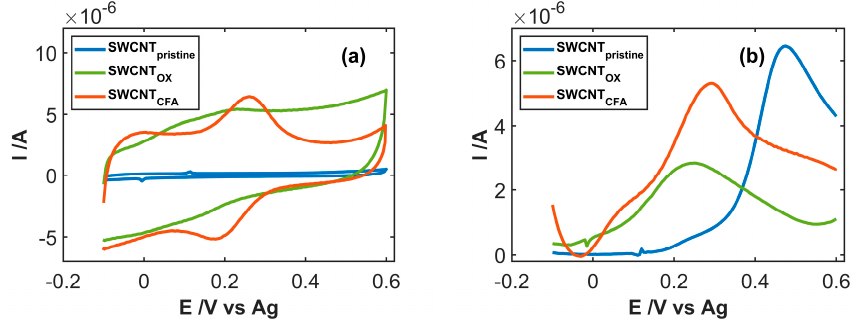
Figure 4. ( a ) CV scan of SWCNT-based electrodes recorded in 0.1 M PBS; ( b ) forward CV scan on the same electrodes in 2·10 − 4 M NADH, 0.1 M PBS solution, subtracted for the relevant background signal.